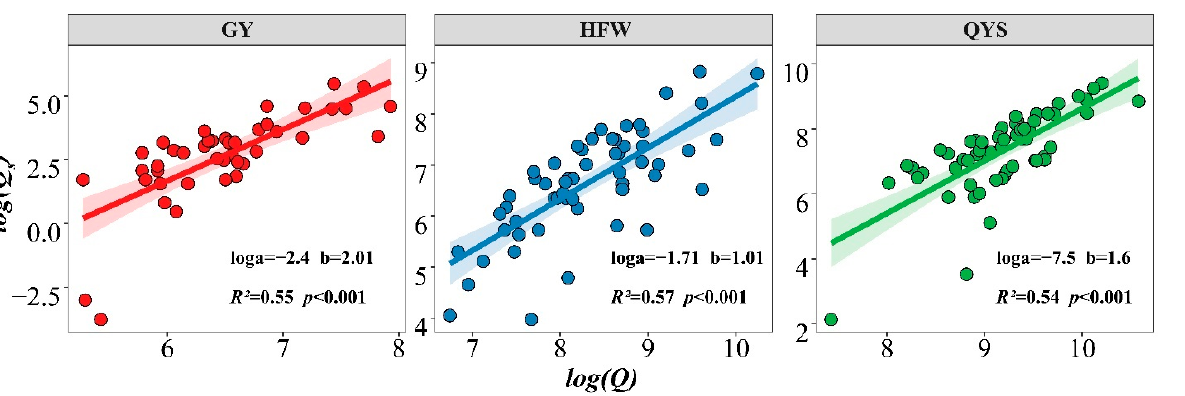
Figure 8. Trends in the parameters a and b of SRCs for four hydrological stations: ( a ) YZ, ( b ) HB, ( c ) HFW, and ( d ) QYS. 3.3. Relationship between Precipitation, Vegetation, and Erosion To reveal the influence of precipitation–vegetation coupling on erosion processes, scatterplots between precipitation, vegetation, and erosion were plotted separately. Fig- ure 9 depicts the correlation between precipitation and NDVI based on the monthly NDVI and precipitation from six sub-basins during 2006–2016. The vegetation cover increased